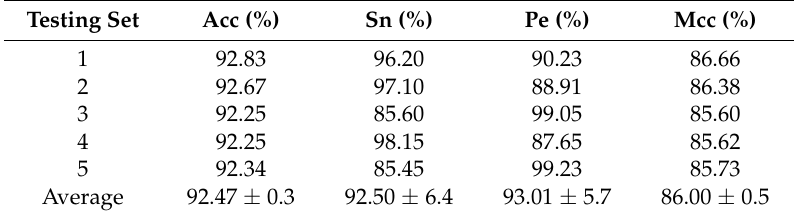
Table 3. Five-fold cross-validation results using the SVM-based method on the Yeast dataset.